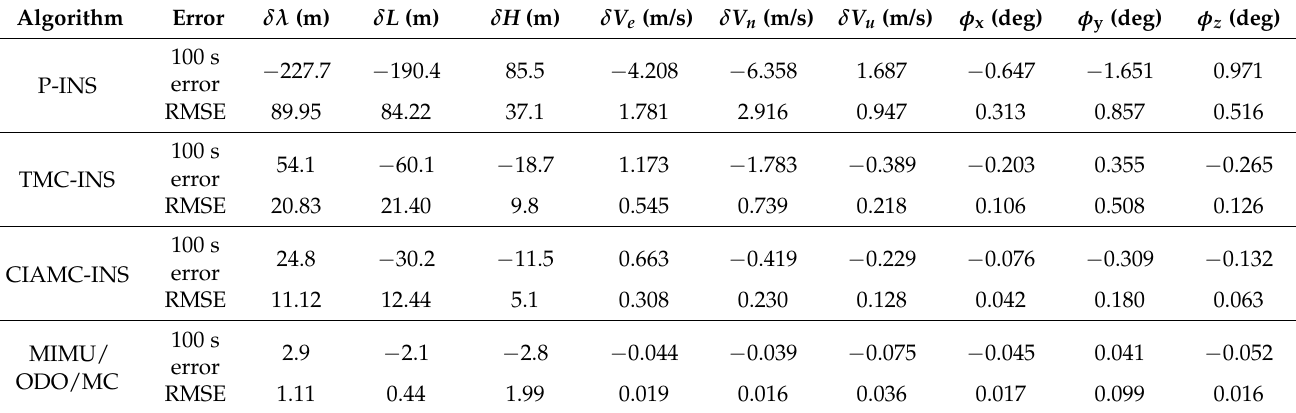
Figure 13. Attitude error curves of four algorithms without GNSS signal. ( a ) Pitch angle error curves; ( b ) roll angle error curves; ( c ) heading angle error curves. Table 3. Navigation errors of different algorithms at the reference point near the 9063 m tunnel exit.